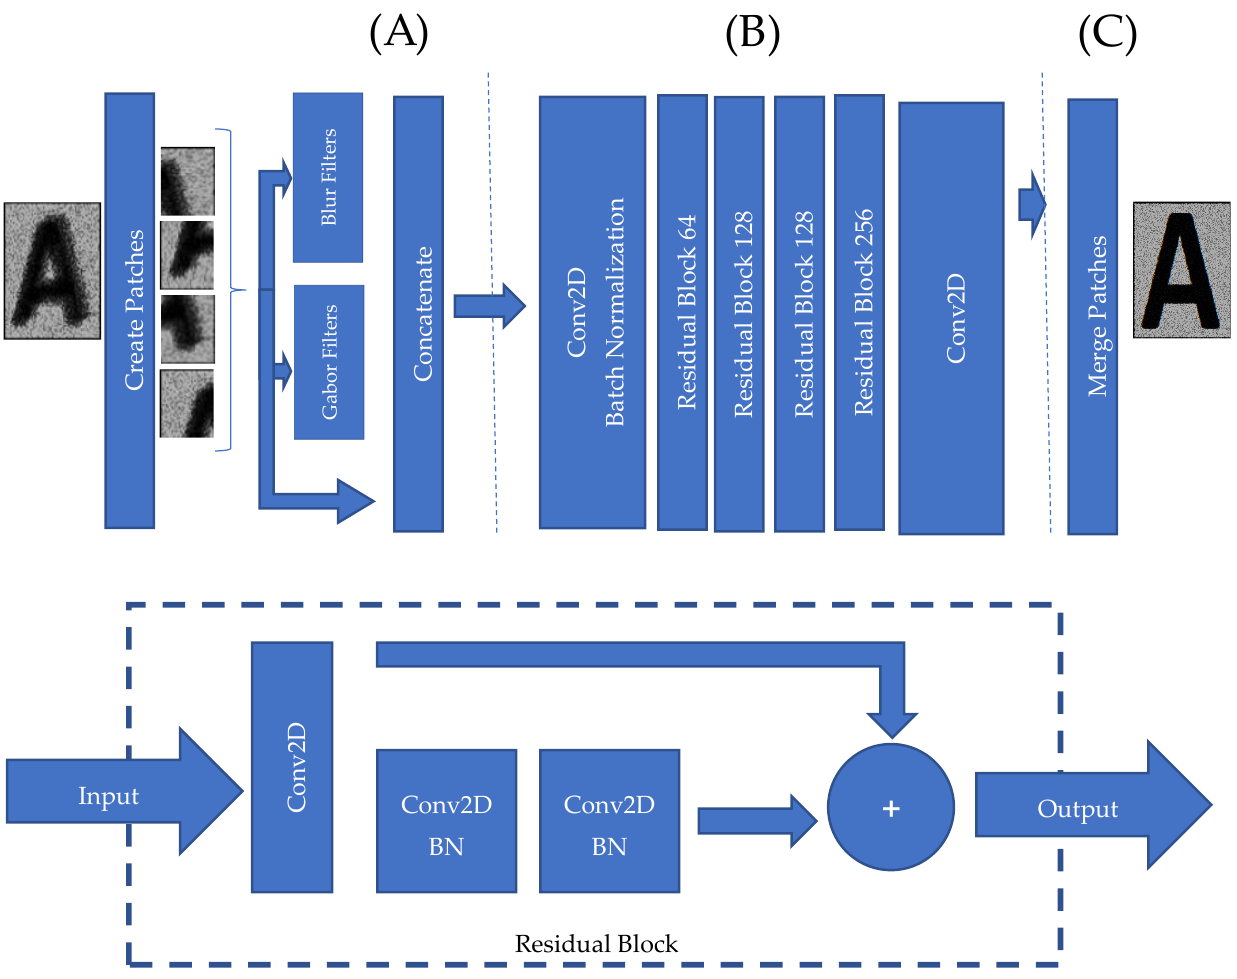
Figure 4. Our novel CNN model architecture (Modules 1 and 2, see Figure 3) for enhancement. Notice that the input image is split into the patches, here just an example for illustration, into four sub-images (each of which have 3 RGB channels). The patches (i.e., the patch concept) will then be applied to each of these 4 sub-images.